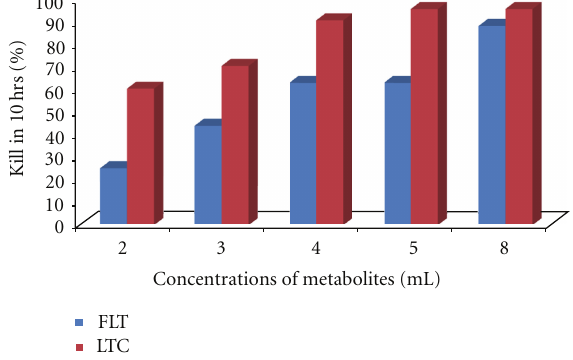
Figure 3: E ff ect of combine metabolites of Fusarium oxysporum , Lagenidium giganteum , Trichophyton ajelloi (FLT), and Lagenidium giganteum, Trichophyton ajelloi, Culicinomyces clavisporus (LTC) on Culex